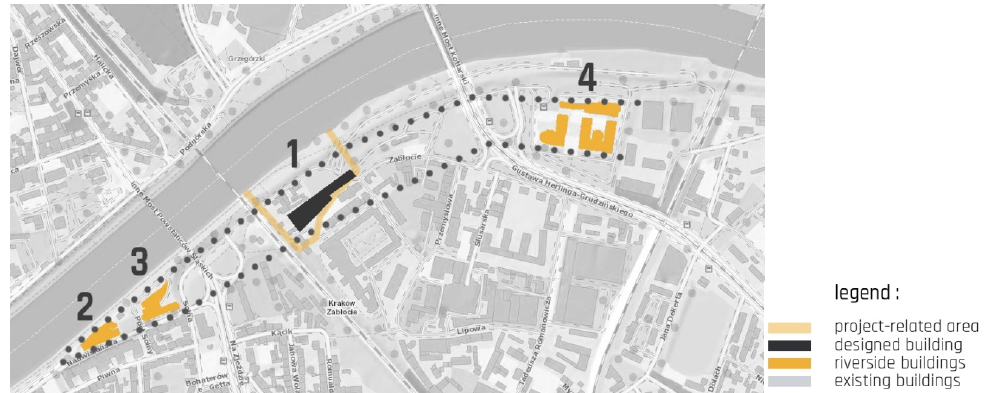
Figure 18. Design concept in the context of surrounding building development: (1) Project-related area; (2) Crikoteka; (2) Qubus Hotel; (3) Cracow Academy (elaborated by E. Latusek).